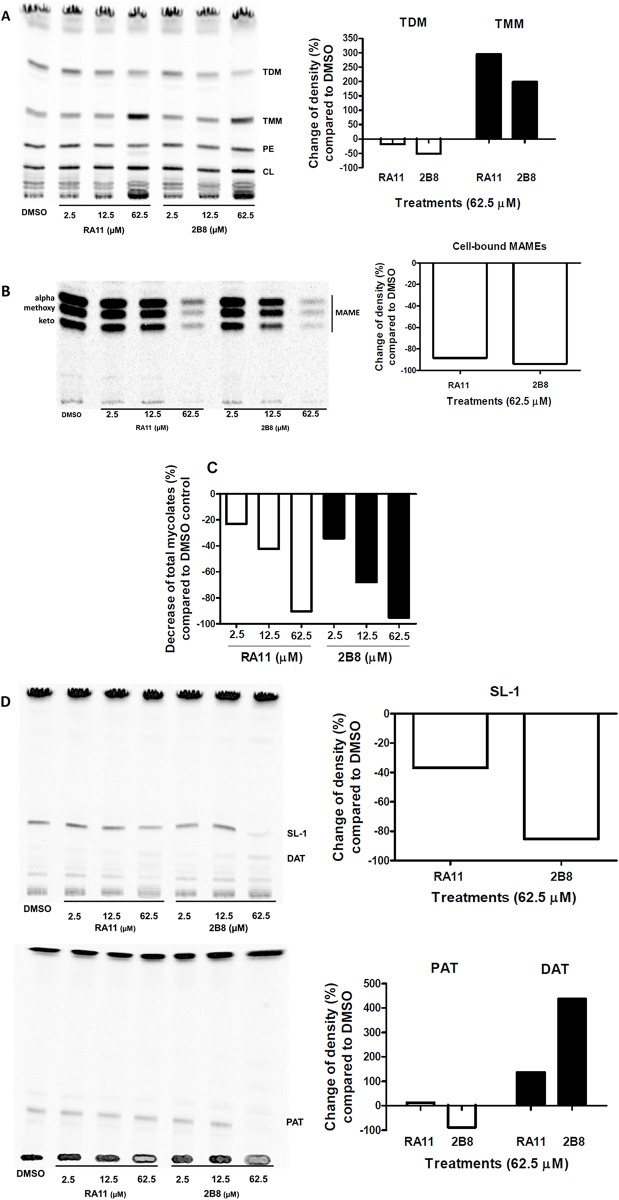
2-AI treatment alters cell envelope lipid composition of M. tuberculosis.Radioactive metabolic labeling was performed on M. tuberculosis H37Rv mc2 6206 treated with increasing concentrations of 2-AI compounds (2.5, 12.5, and 62.5 μM) for 24 h. TLCs (left) of a representative experiment are shown with quantified comparison between specific bands as measured by densitometry (right). A) For visualization of TDM, TMM, PE and CL (A), a total of 10,000 cpm was loaded per lane and TLCs were developed in chloroform/methanol/water (20:4:0.5, v/v/v). Treatment with 2-AI compounds resulted in reduced levels of TDM, but increased TMM. B) TLC of cell wall associated mycolates is shown (Left panel). For visualization of MAMEs in cell-bound lipids, hexane/ethyl acetate (95:5, v/v, three developments) solvent system was used and samples were loaded volume to volume. C) Samples treated with 2-AI showed reduced levels of total mycolate biosynthesis (sum of MAMEs from cell-bound, B, and extractable lipids, S3 Fig). D) TLCs were developed in chloroform/methanol/water (90:10:1, v/v/v) for visualization of SL-1 and DAT, and petroleum ether/acetone (92:8, v/v) for visualization of PAT. Treatment with 2-AI compounds reduced the amount of SL-1 and PAT, but increased DAT. All TLCs were quantified by densitometry analysis (right panels). Experiments were carried out three separate times and representative data are shown. PE: phosphatidylethanolamine, CL: cardiolipin.